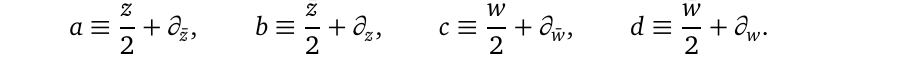
(cid:112) 2 from left to